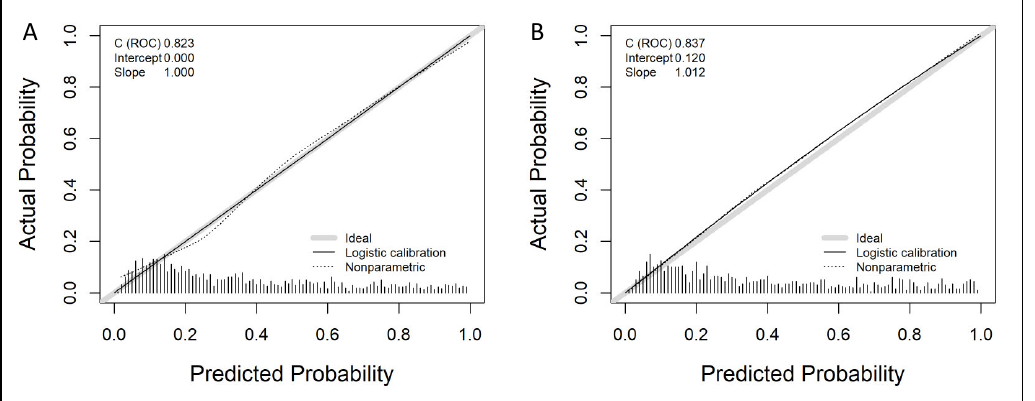
Figure 2. Calibration curves of predictive model in development cohort ( A ) and validation cohort ( B ).